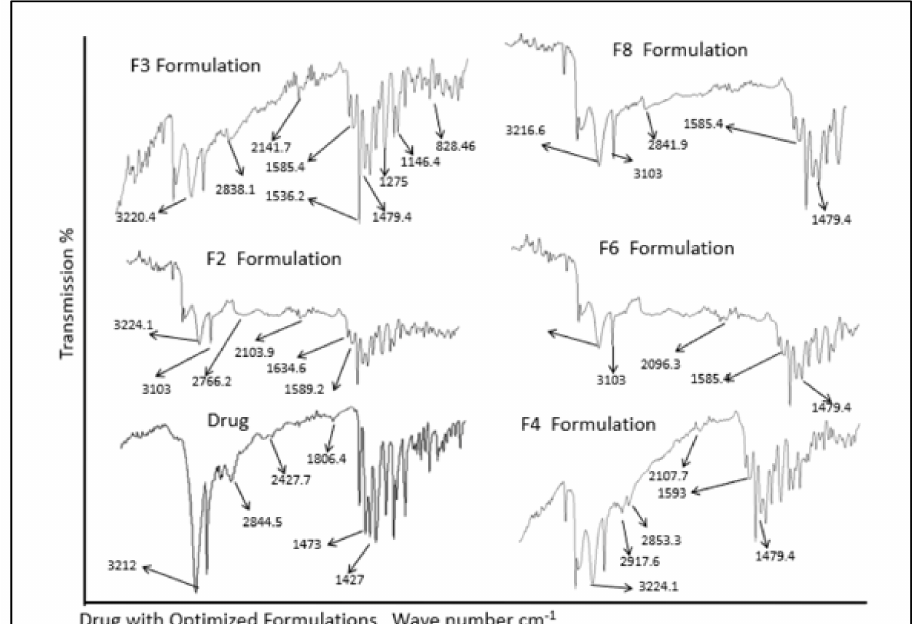
Figure 2. ATR-FTIR spectra of drug and